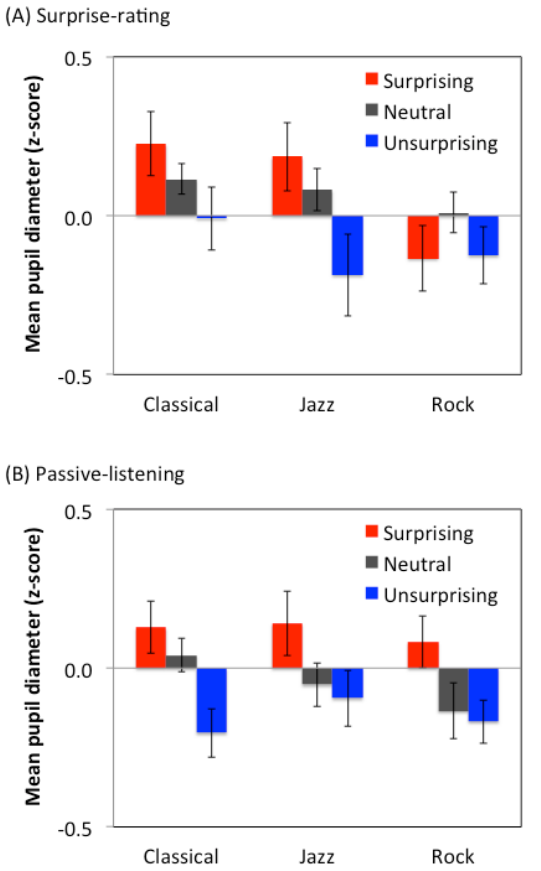
Fig. 2. Mean of the pupil diameter during the surprising, neutral, and unsurprising moments parameterized by music type in surprise-rating (A) and passive-listening (B) sessions. Error bars represent standard errors across participants.